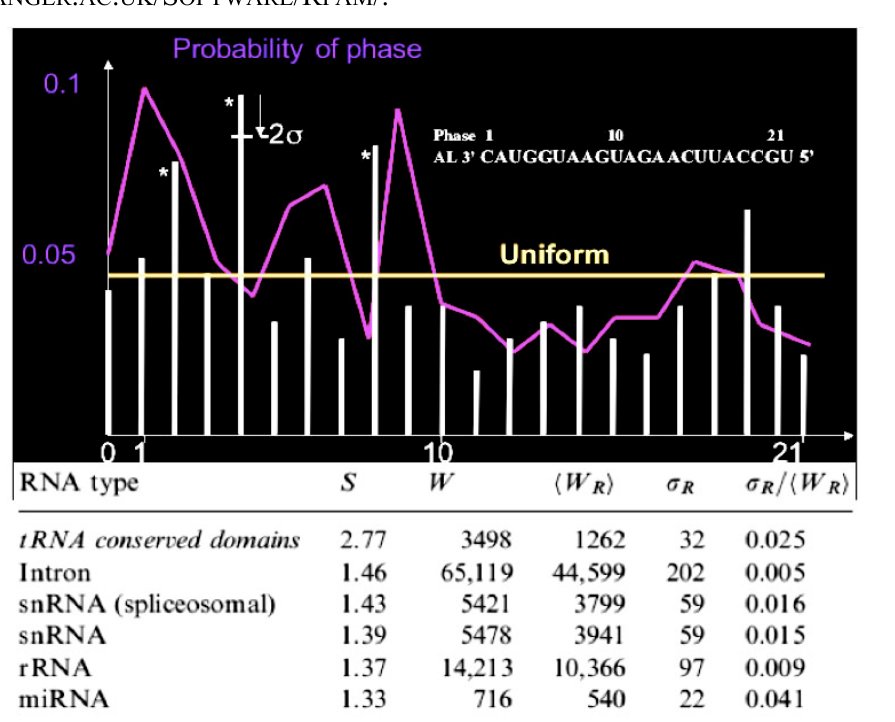
Figure 5. Phase histogram among the best matches between human miRs and AL (white bars) and between human miRs and the 29,520 rings (violet curve); number W of common substrings of length ≥ 5 between RNAs and AL, mean number < W